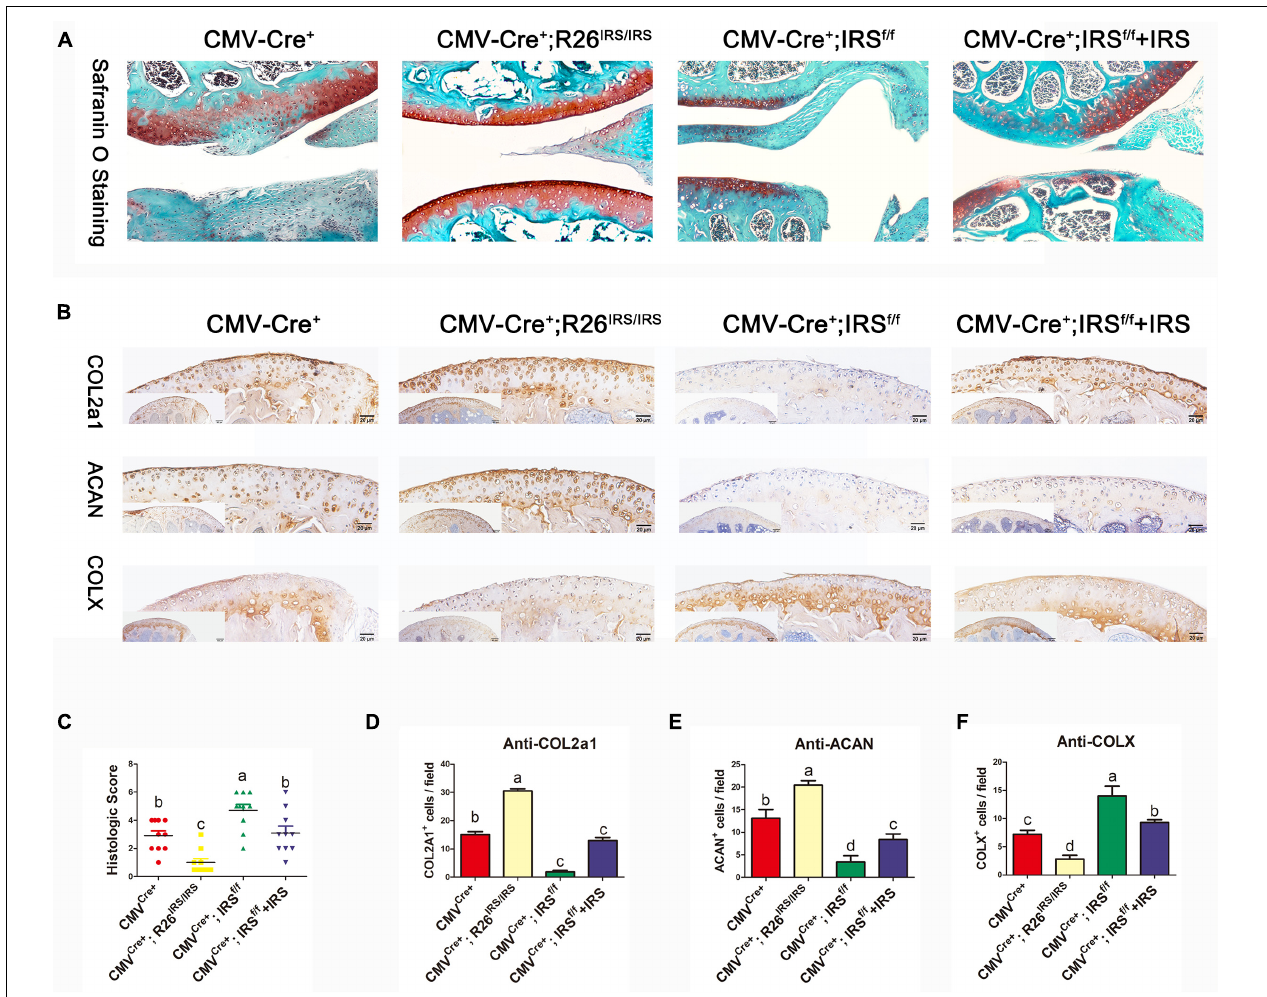
FIGURE 4 | Immunohistochemistry analyses of articular cartilages in medial meniscus (DMM) OA model mice ( n = 6). (A) Safranin O staining. (B) IHC staining. (C) Osteoarthritis Research Society International (OARSI) scores in mouse DMM models. (D–F) Immunostaining positive cells were counted. The comparing data between groups shown in lowercases ( a, b, c, and d) are mean values with statistical significance ( P < 0.05).